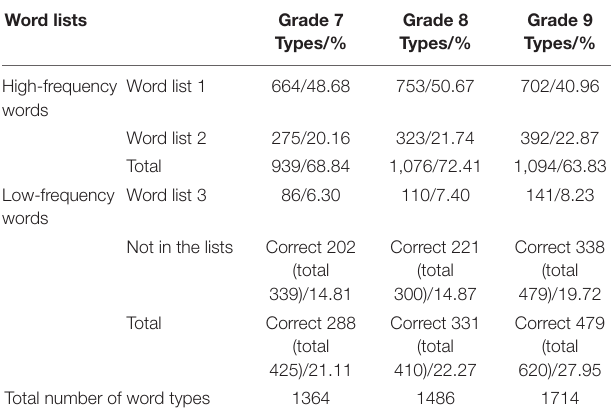
TABLE 1 | Number and percentage of word types per word list and per grade